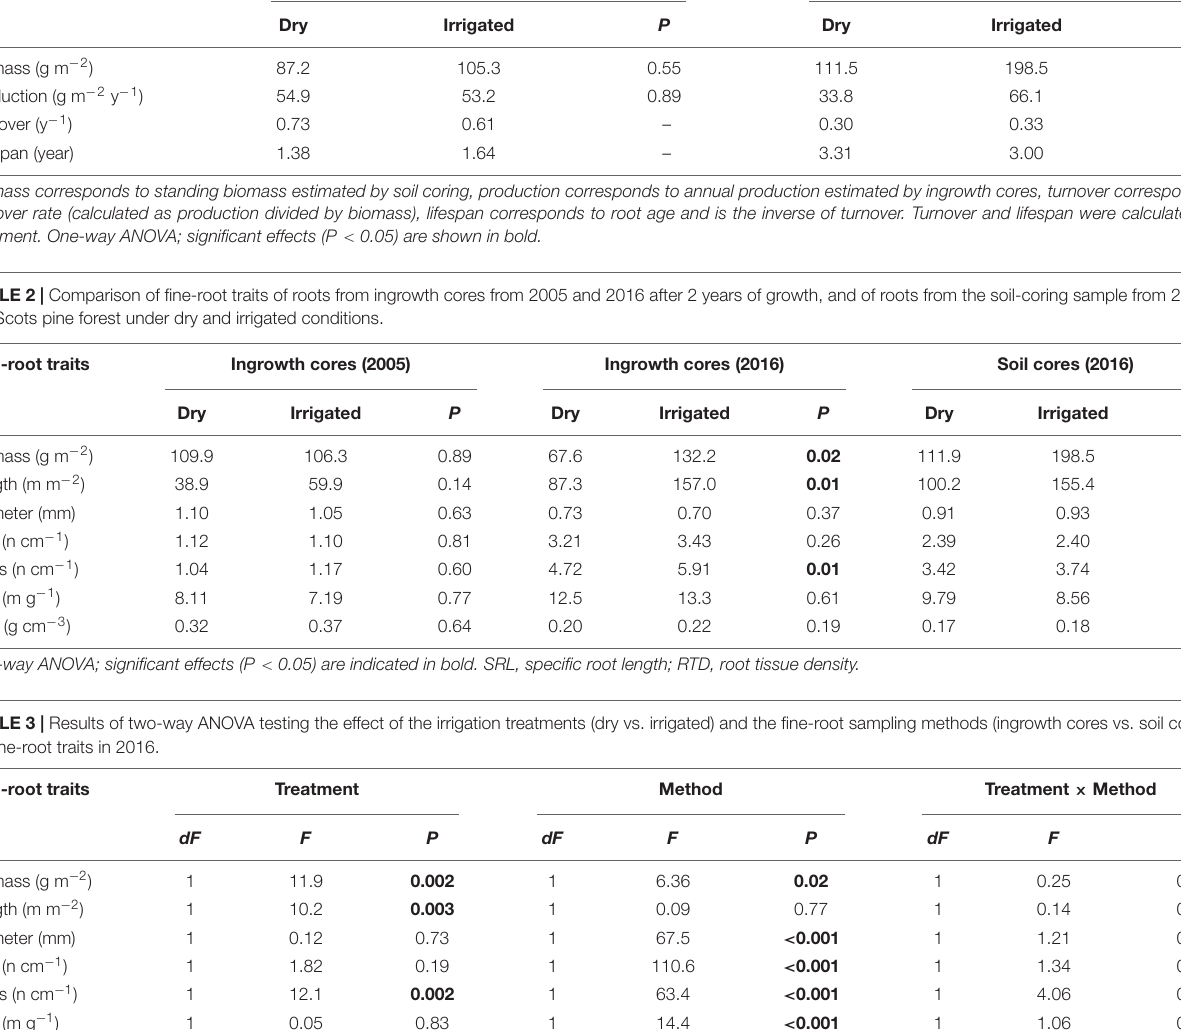
TABLE 1 | Biomass, production, turnover rate, and lifespan of fine roots in the years 2005 and 2016 of the Scots pine forest under dry and irrigated conditions. Fine-root traits